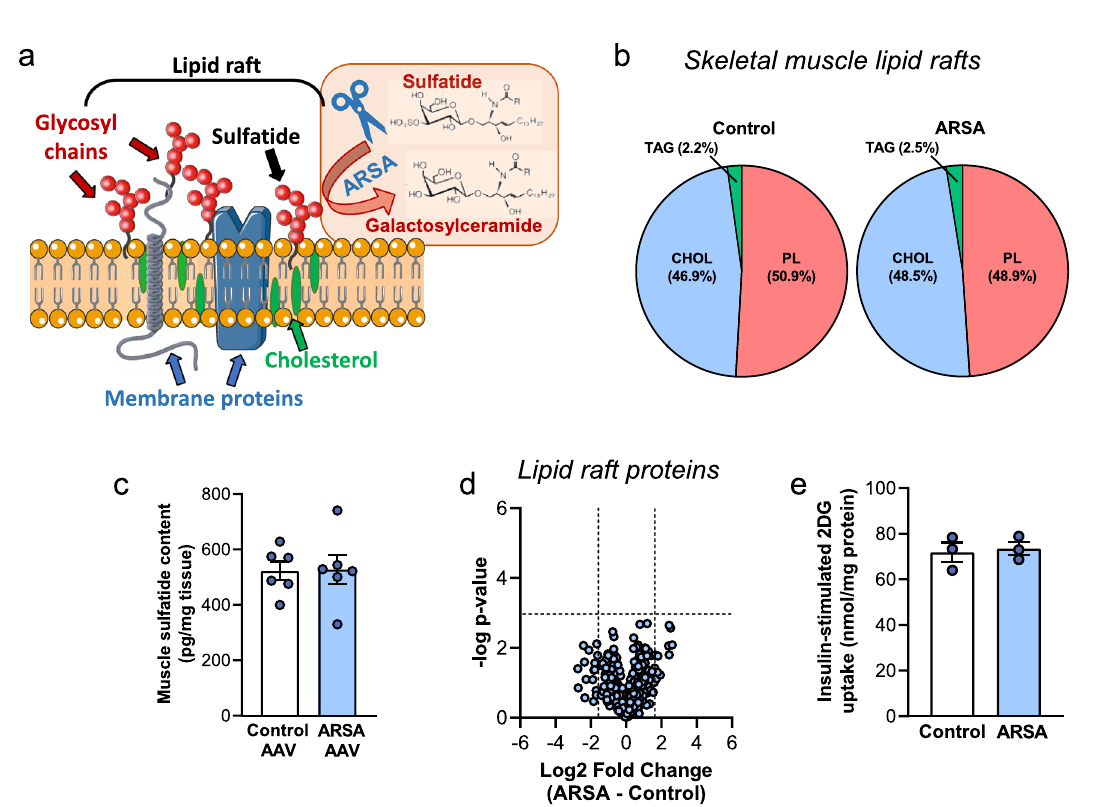
Fig. 5 Liver-derived ARSA does not modulate skeletal muscle lipid rafts. a ARSA degrades sulfatides that are primarily localized to cell surface lipid rafts, which are microdomains enriched in cholesterol, sphingolipids, and membrane proteins. b Skeletal muscle lipid raft composition, shown as a percentage of the major lipid classes (average of n = 6/group). CHOL cholesterol, PL phospholipid, TAG triglyceride. c Skeletal muscle sulfatide content in Control-AAV (white bar) and ARSA-AAV (blue bar) mice ( n = 6/group). d Volcano plot showing no difference in the proteins contained in skeletal muscle lipid rafts derived from Control-AAV and ARSA-AAV mice. e 1- 14 C-2-deoxyglucose (2-DG) uptake into differentiated C2C12 myotubes following 24 h incubation without (white bar) or with ARSA (10 ng/mL, blue bar) ( n = 3/group, from three individual experiments). Data are means ± SEM. Data assessed using two- tailed unpaired t tests ( c , e ). Source data are provided as a Source Data fi Thy1/CD90 and absence of proteins enriched in other organelles effects associated with ARSA, we next aimed to determine how (Supplementary Fig. S5B). Similar to a previous report 29 , lipid liver-derived ARSA improves skeletal muscle insulin action, rafts contained on average 47% cholesterol and 50% phospholi- focussing on ARSA ’ s primary known function, which is the pids, in addition to sphingolipids, triacylglycerols, diacylglycerols, breakdown of sulfatide lipids localized primarily to lipid rafts on and lysophospholipids (Fig. 5b). Unexpectedly, muscle sulfatide the cell surface 27 (Fig. 5a). Skeletal muscle lipid rafts were isolated content was not different between ARSA-AAV and Control-AAV using sucrose gradient centrifugation 28 (Supplementary Fig. S5A) mice (Fig. 5c). Lipidomic analysis revealed very few differences in and purity was con fi rmed by enrichment of the lipid raft protein